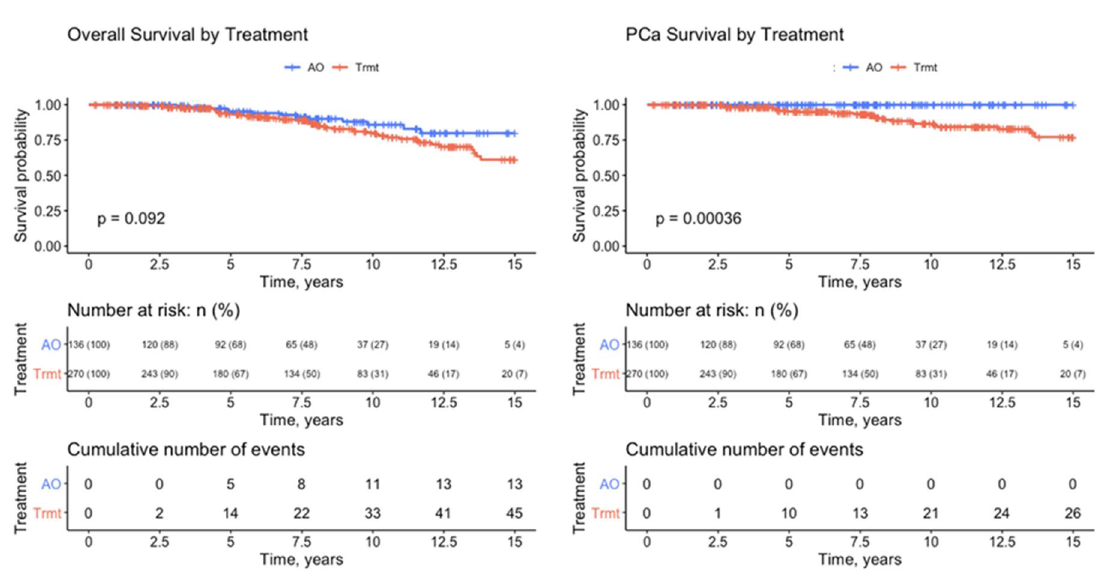
Figure 1. Kaplan–Meier analysis of overall survival and prostate-cancer-specific survival in the active observation ( n = 136) and treatment ( n = 271) groups. Table 1. Demographics of BCR patients in the AO (N = 136) and treatment ( n = 271) groups. Table 2. Full univariate (A) and multivariate (B) regression analysis in all BCR patients ( n = 407) for no treatment and for initial PSADT (C) and DT pattern (D) models